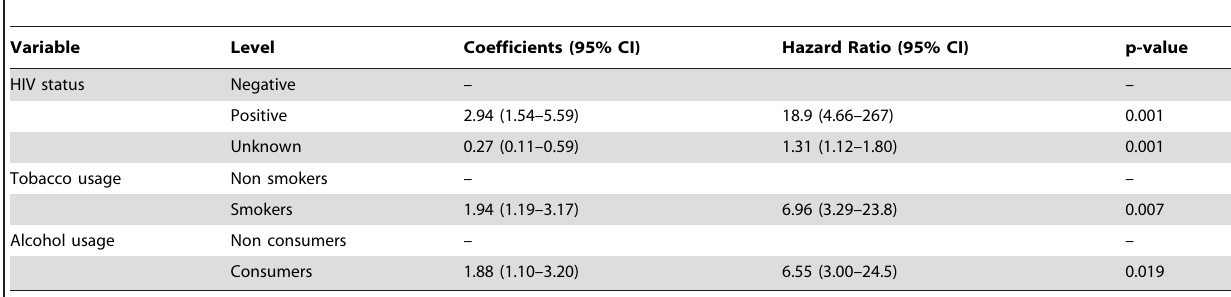
Table 5. Cox proportional hazard model of the time to detection of M. tuberculosis bacilli on MGIT960 based on 344 patients at the Mubende referral